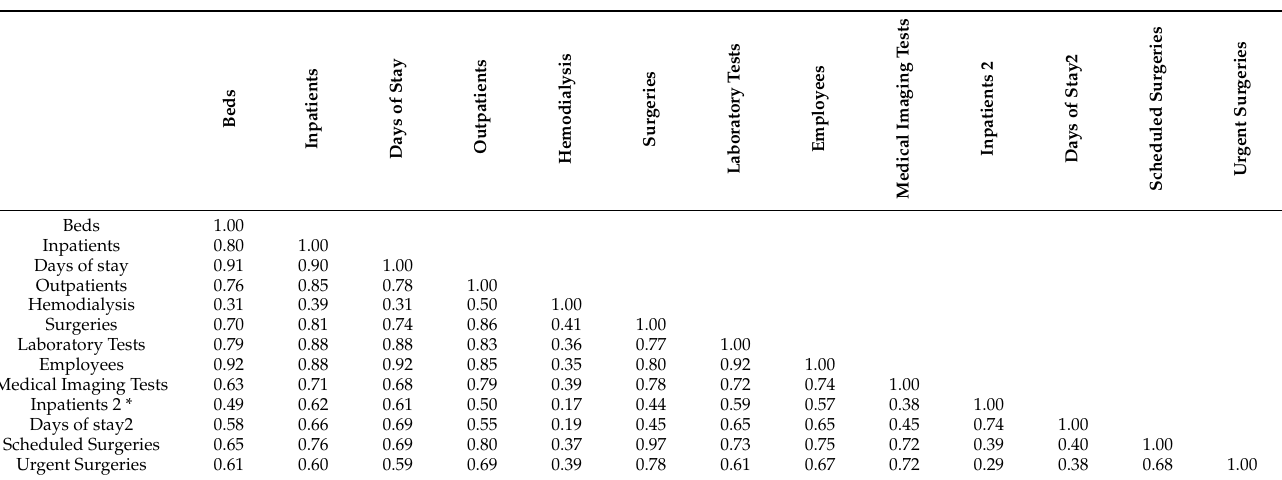
Table 2. Pairwise correlations of the independent variables.